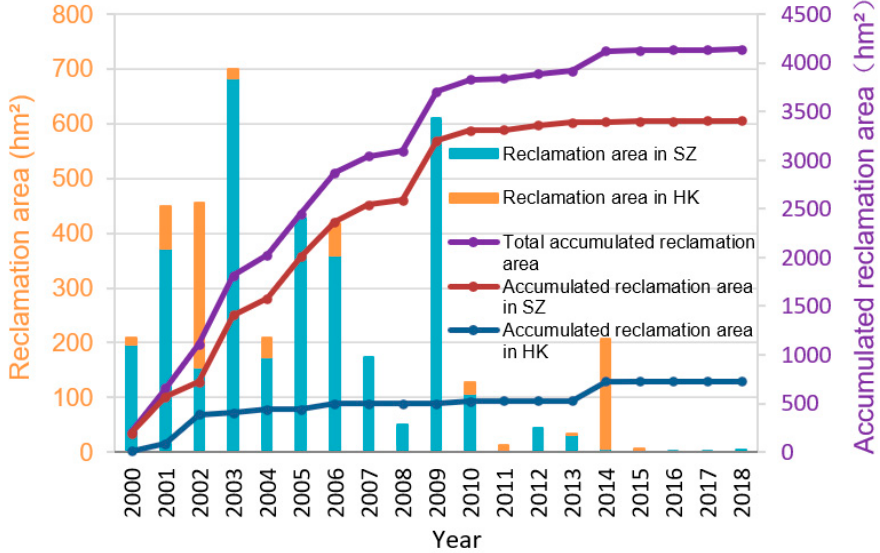
Figure 6. Time series of the coastal reclamation areas in Shenzhen and Hong Kong. The horizontal axis is the year, the left vertical axis is the annual coastal reclamation area, and the right vertical axis is the cumulative coastal reclamation area. The bar graphs are the annual coastal reclamation area in Shenzhen and Hong Kong, and the curves are the cumulative coastal reclamation area and the total coastal reclamation area in Shenzhen and Hong Kong.